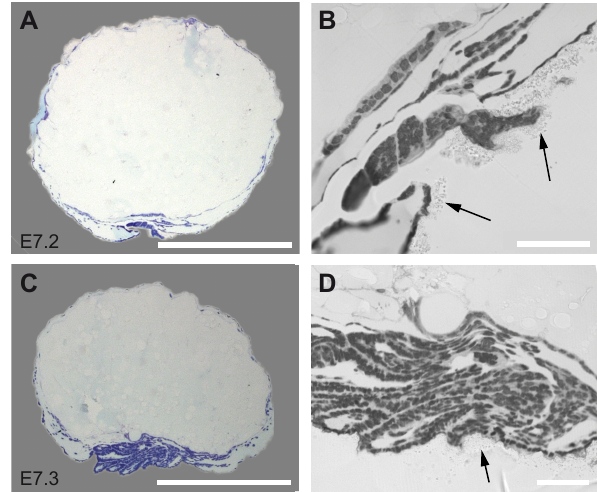
Fig. 7. Histological sections of mineralized pre-heated crayfish eggs showing preservation of embryonic tissue. (A) , (B) After two weeks, experiment E7.2. (C) , (D) After three weeks, experi- ment E7.3. Various cell types and components (e.g. cell nuclei of the segmented caudal papillae) are exceptionally well preserved and fine-grained brushite and calcite crystals (arrows) completely replicate the degraded endochorional envelope (Scale bars: A and C =500µm; B and D